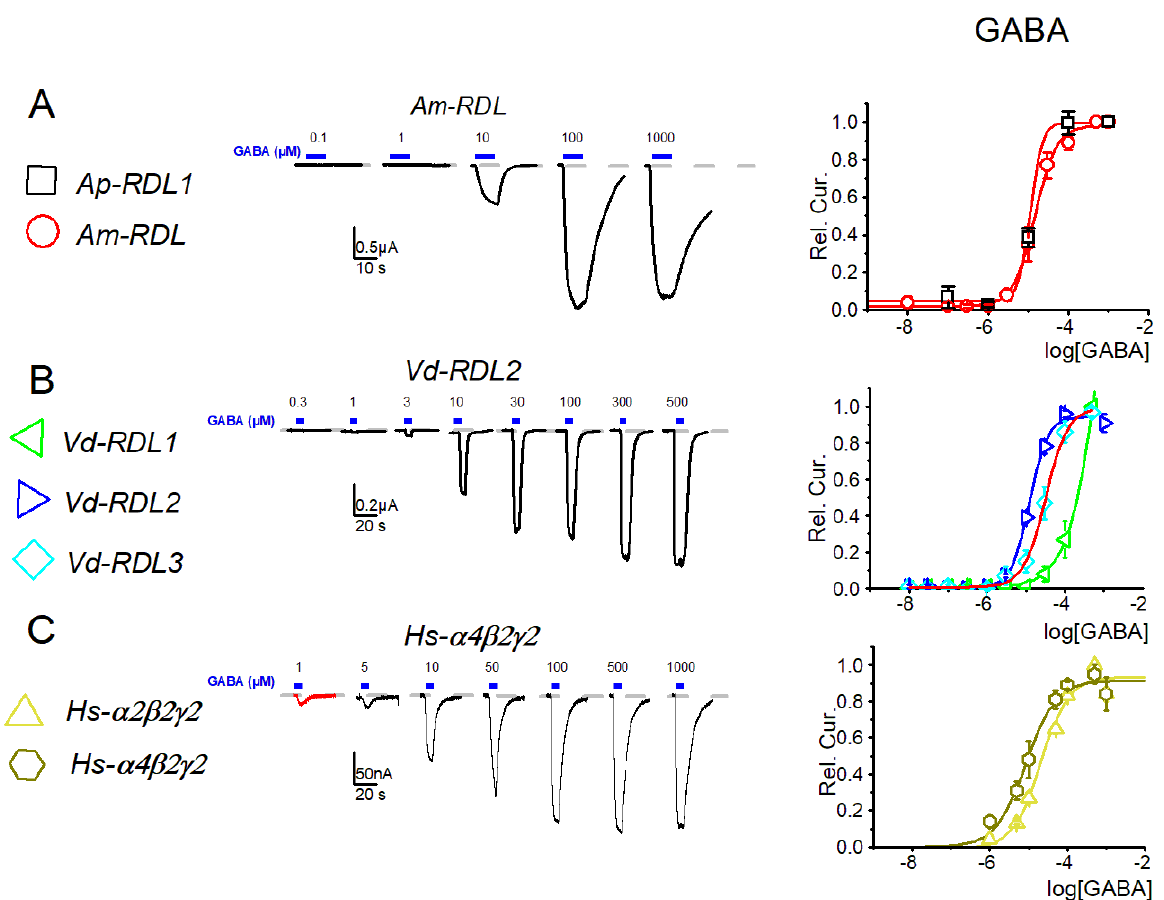
Figure 3. Dose–response curves for GABA of seven GABA-A receptors: RDL of A. pisum and A. mellifera ( A ) RDL1, RDL2 and RDL3 of V. destructor ( B ), and α 2 β 2 γ 2 and α 4 β 2 γ 2 of H. sapiens ( C ). Left exemplar current traces from 1 type of receptor, right full dose–response curves of the seven GABAr types. The EC 50 are summarized in Supplementary Table S1.